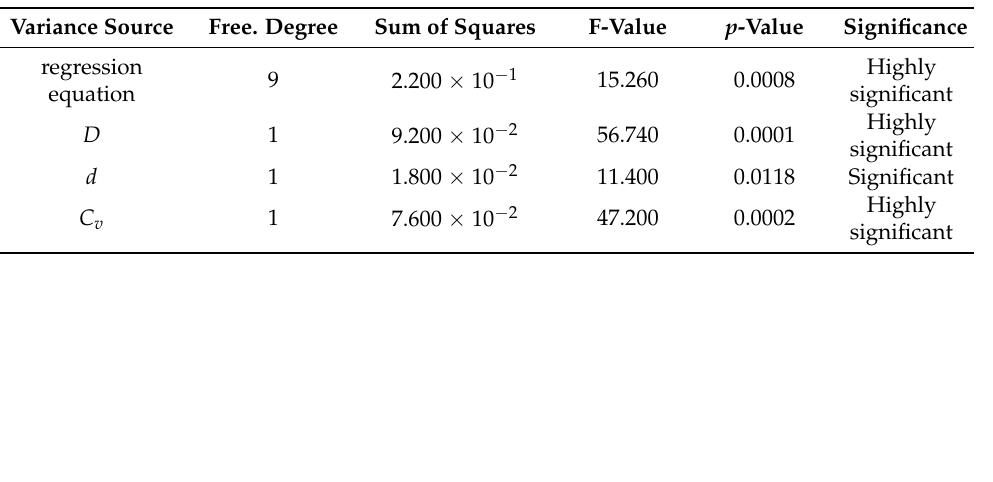
Table 5. Variance analysis of response function model for yield stress.